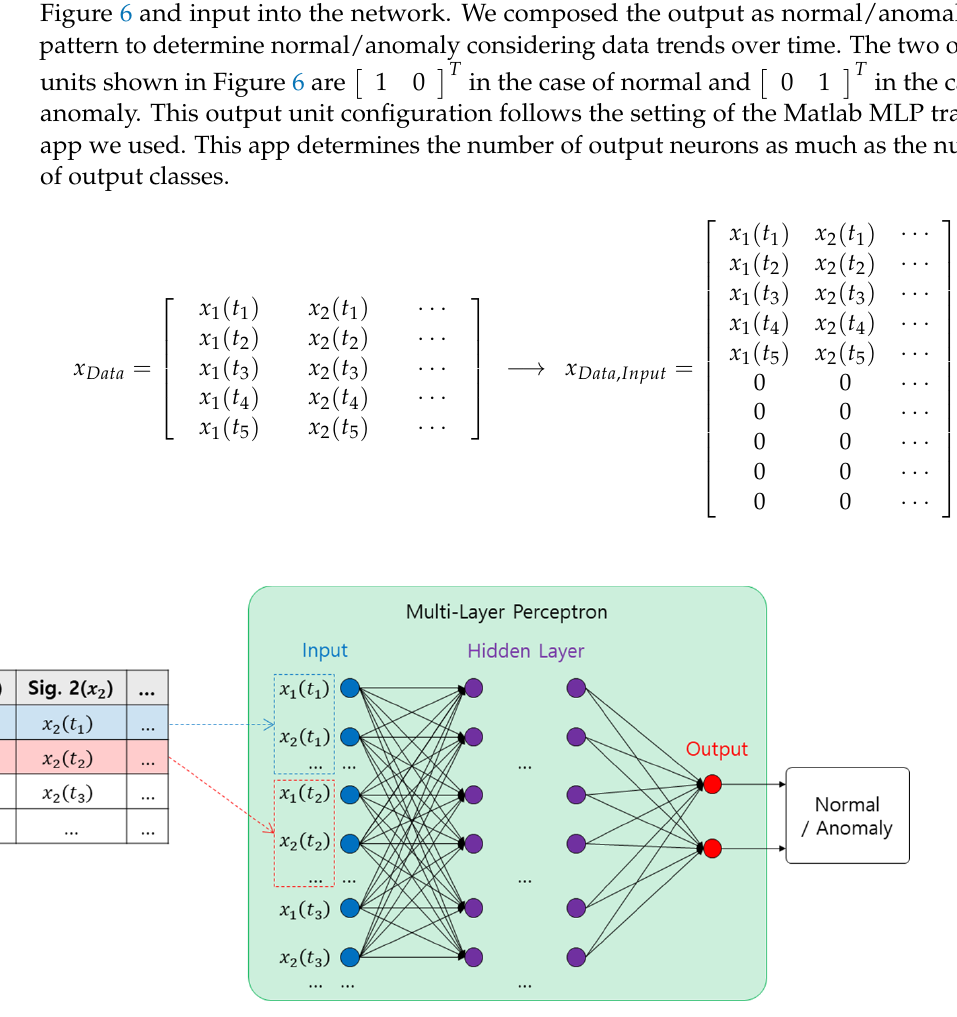
Figure 6. MLP-based anomaly detection model training architecture.